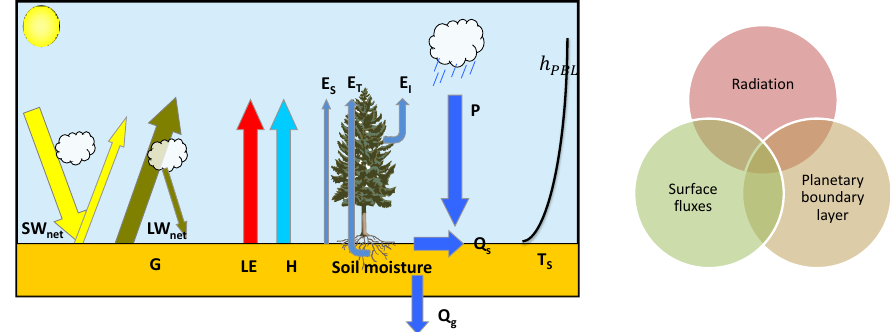
Figure 1. HOLAPS drivers, estimated surface fluxes and surface fluxes and modules.